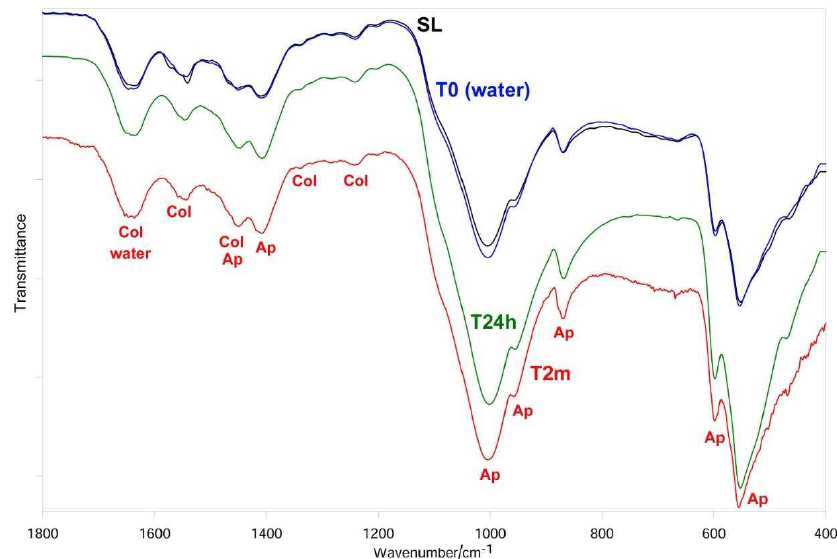
Figure 10. Average IR spectra recorded on the control dentin surface after sanding (SL, black), treatment with water (blue), aging in SBF for 24 h (T24h, green) and two months (T2m, red). The bands prevalently assignable to collagen (Col), water, and B-type carbonated apatite (Ap) are indicated.